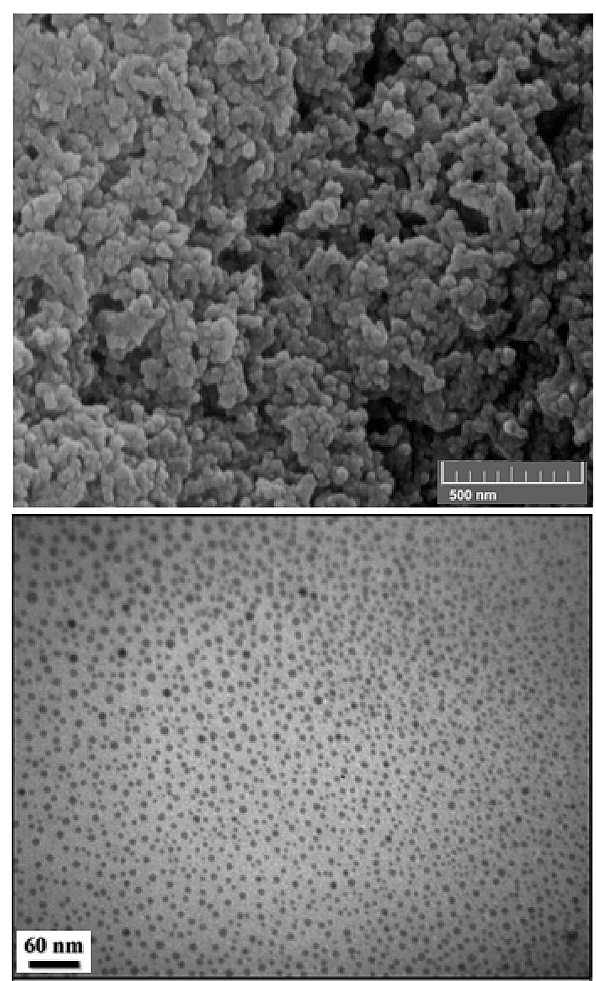
Figure 11. FESEM and TEM images of 7 time reused